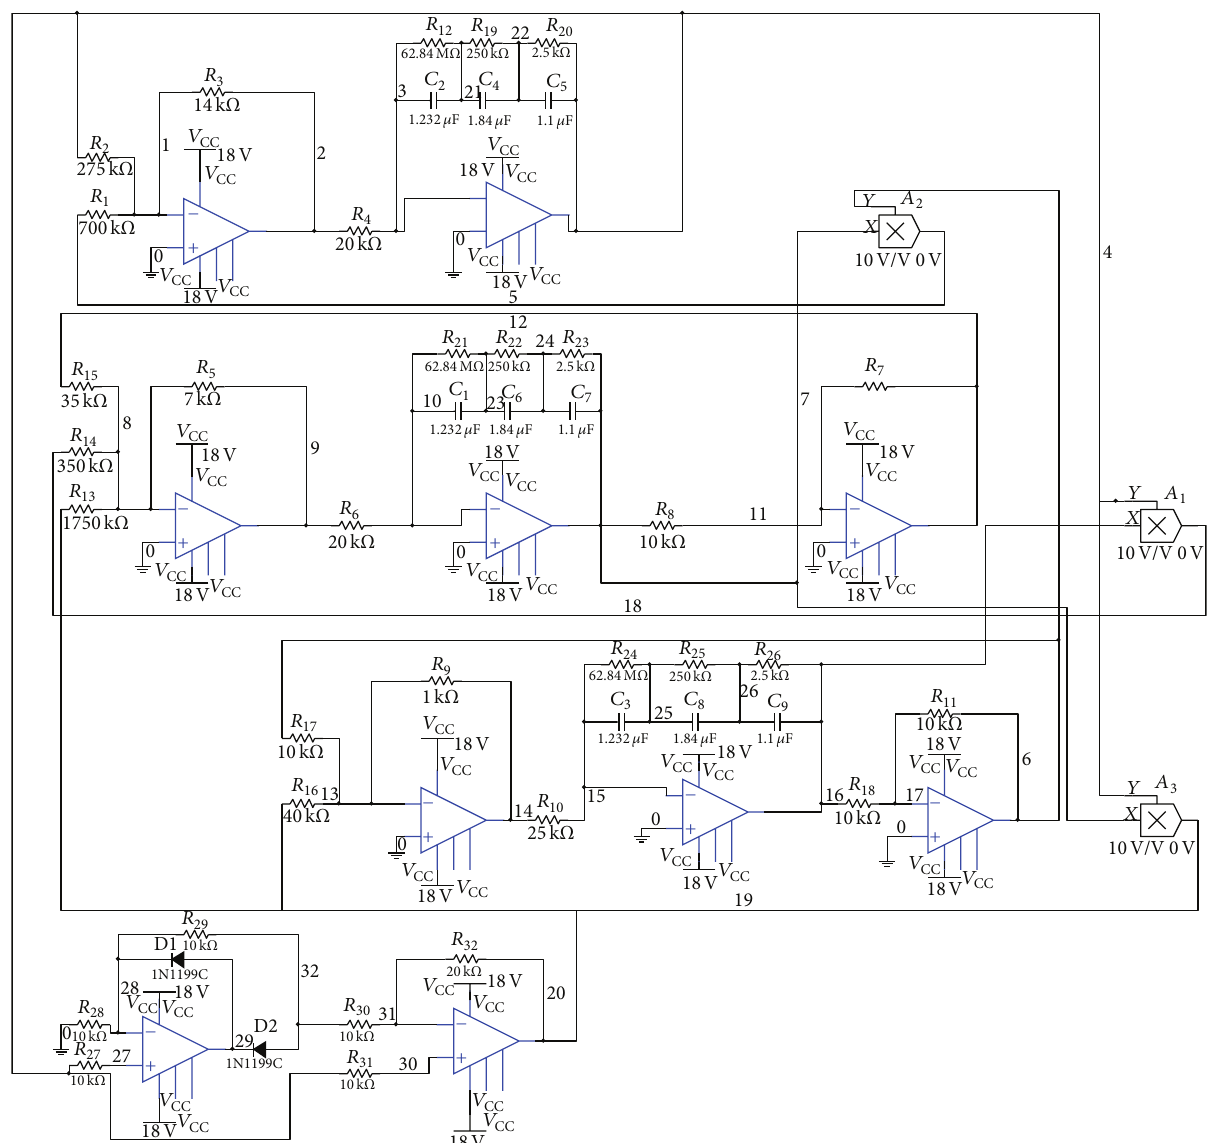
Figure 6: Circuit diagram to realize the new wing doubled fractional-order chaotic system